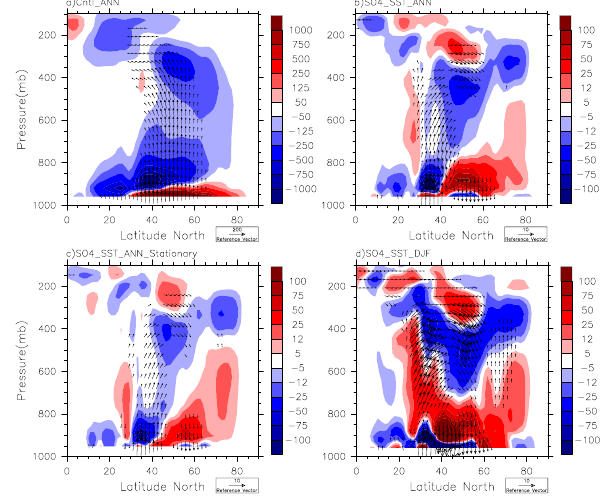
Figure 5. The Eliassen–Palm (EP) flux (vector) and its divergence (contour). (a) The climatology. (b) The change due to SO 4 -induced SST perturbation (SO 4 _SST). The convergence (blue) and diver- gence (red) of the EP flux correspond to a deceleration and accel- eration of the westerly mean flow, respectively. (c) Contributions of the stationary eddy to the change shown in (b) . This was calculated using a 10-day average, instead of a daily average. Transient ed- dies are the difference between the total and stationary contribution (not shown). (d) NH winter (DJF) average, not the annual average shown (b) . Note that the color scale and reference vectors are dif- ferent across the